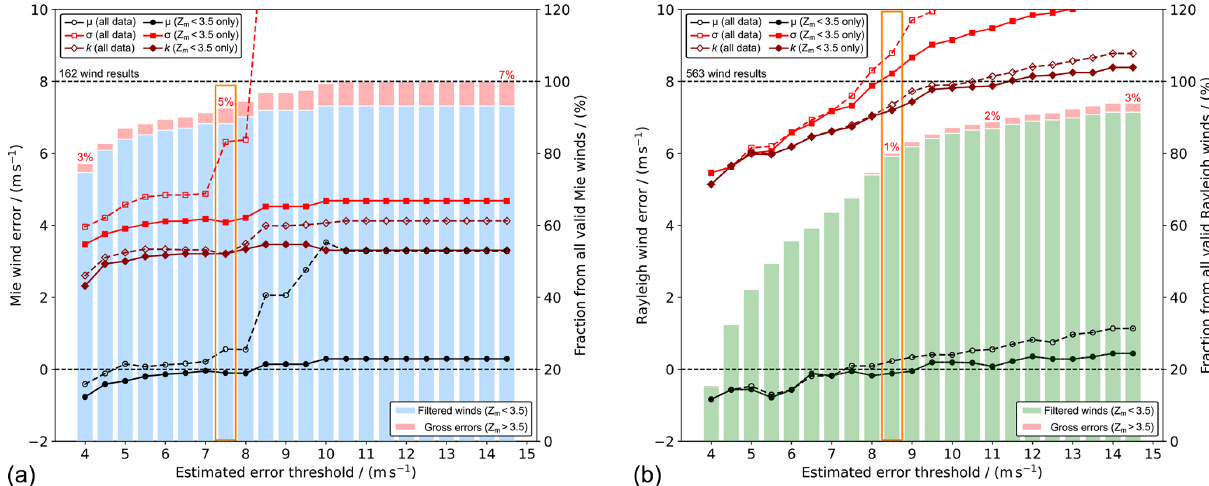
Figure 8. Same as Fig. 6 but for the statistical comparison of L2B Mie-cloudy (a) and Rayleigh-clear winds (b) against 2µm DWL wind data. The EE thresholds that are deemed reasonable for providing robust statistical results are highlighted by orange frames (see also Fig. 9).